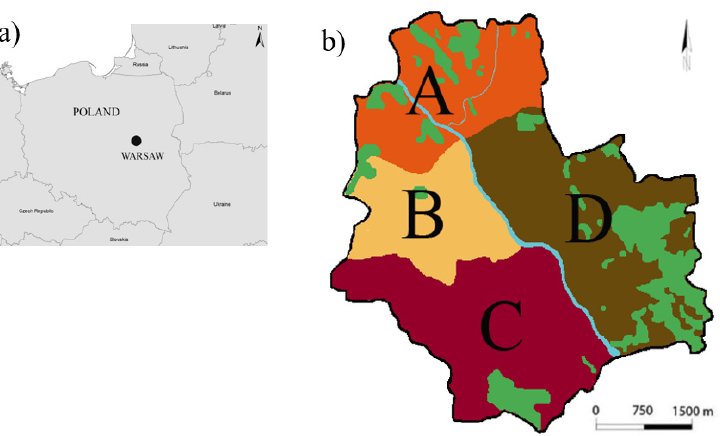
Figure 1. Localization of Warsaw in Poland ( a ) and urban forests (green color) located in four obwody le´sne in Warsaw ( b ): (A—Bielany-Młociny (orange color); B—Bemowo-Koło (yellow color), C—Kabaty (purple color); D—Las Sobieskiego (brown color)).